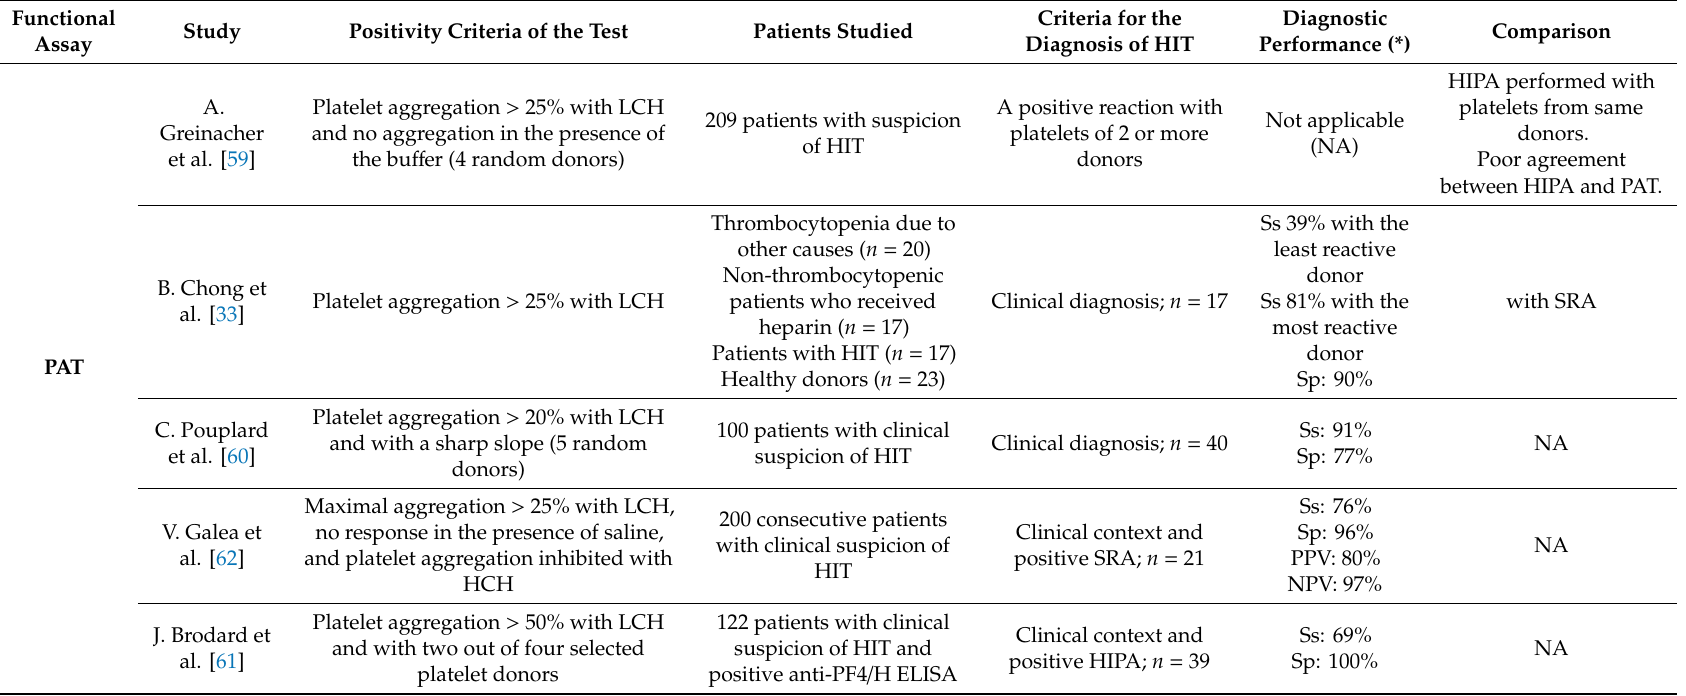
Table 3. Diagnostic performances of the platelet activation tests for the diagnosis of heparin-induced thrombocytopenia (HIT).